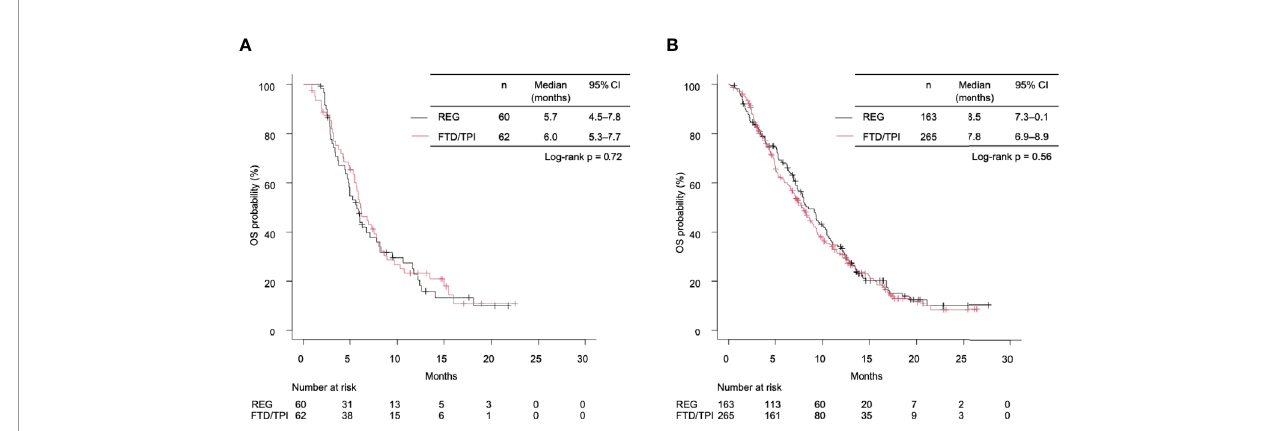
FIGURE 2 | (A) Kaplan-Meier curves of overall survival (OS) strati fi ed by treatment group in right-sided tumors. The median OS times of the REG and FTD/TPI groups were 5.7 months (95% CI 4.5 – 7.8) and 6.0 months (5.3 – 7.7), respectively (log-rank p = 0.72). (B) Kaplan-Meier curves of OS strati fi ed by treatment for left- sided tumors. The median OS times of the REG and the FTD/TPI groups were 8.5 months (95% CI 7.3 – 10.1) and 7.8 months (6.9 – 8.9), respectively (log-rank p = 0.56). REG, regorafenib; FTD/TPI, tri fl